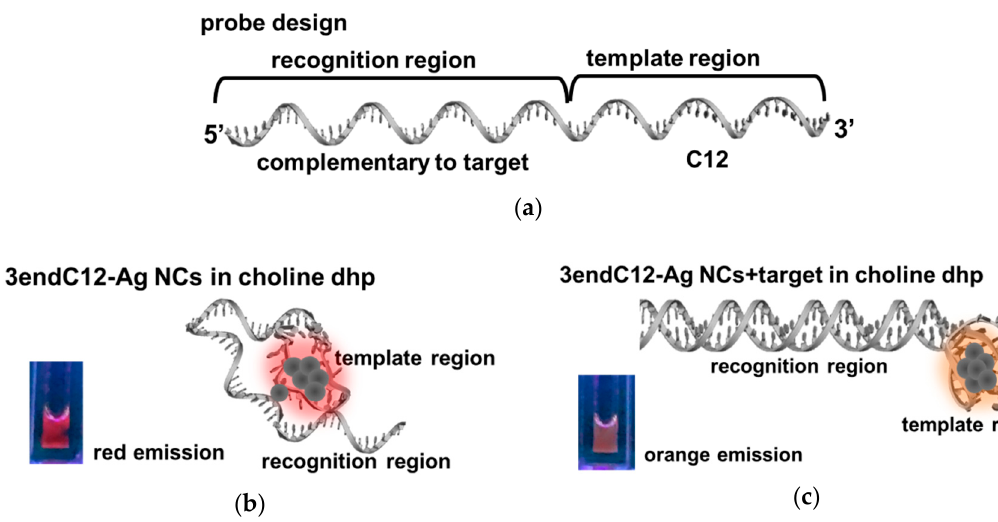
Figure 6. ( a ) The design of the probe and a photo of 3endC12-templated Ag nanoclusters (NCs) ( b ) in the absence and ( c ) presence of a target (the photo was taken during UV light excitation at 254 nm).